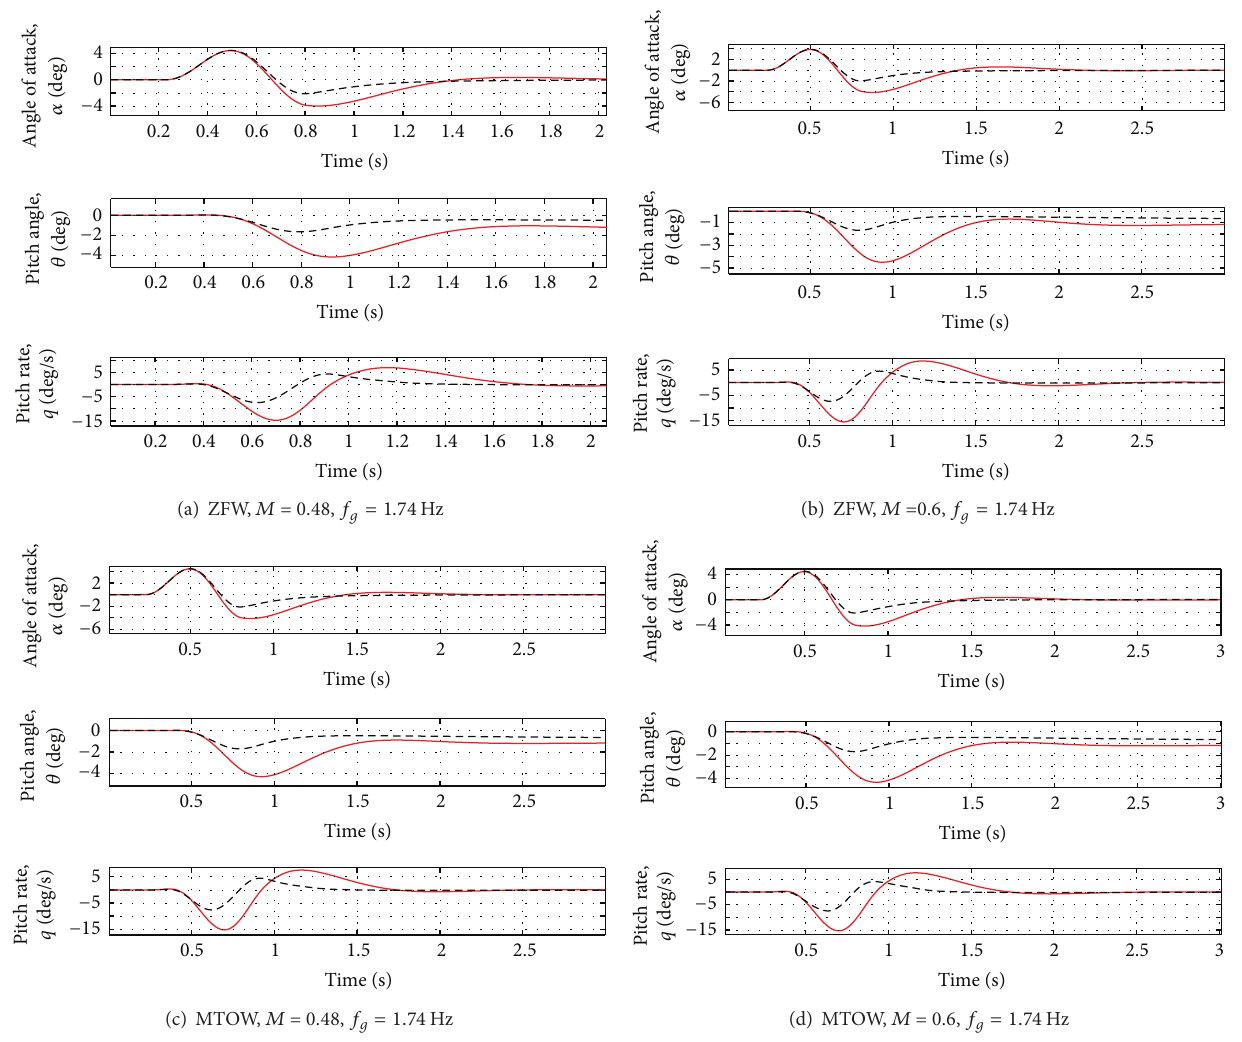
Figure 12: Rigid variable variation for all the cases in Table 5. Red solid line: open loop. Black dotted line: closed loop.